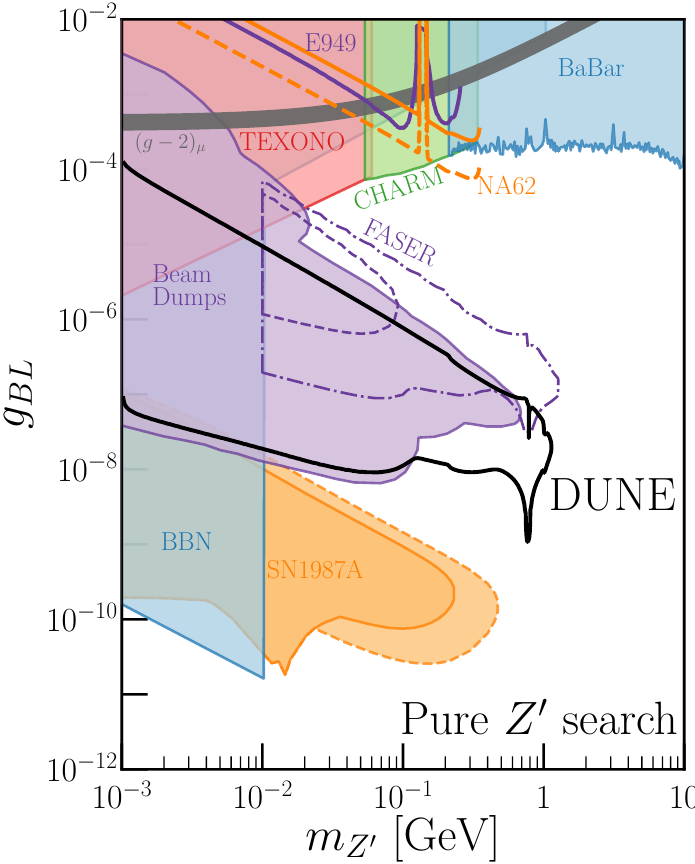
Figure 4 . Prospects of the Pure Z 0 search without the scalar ϕ using the DUNE Near Detector (black) where the black lines encompass parameter space for which at least ten signal events (zero background assumed) are expected. Current limits from beam-dump experiments (shaded pur- ple) from ref. [37], TEXONO (shaded red) [51, 52], CHARM (shaded green) [53], BaBar (shaded cyan) [54], E949 (purple line) [55] and NA62 (orange line) [56], and BBN (shaded blue) [57] are also shown. The dark (solid) and faint (dashed) orange regions are respectively the conservative and ag- gressive SN1987A limits [58]. The gray band denotes the preferred region for muon g − 2 anomaly at the 2 σ C.L. [59, 60]. Also shown are the prospects from future NA62 data (dashed orange line) [61], FASER (dashed purple line) and FASER2 (dot-dashed purple line) [62]. See text for more details.